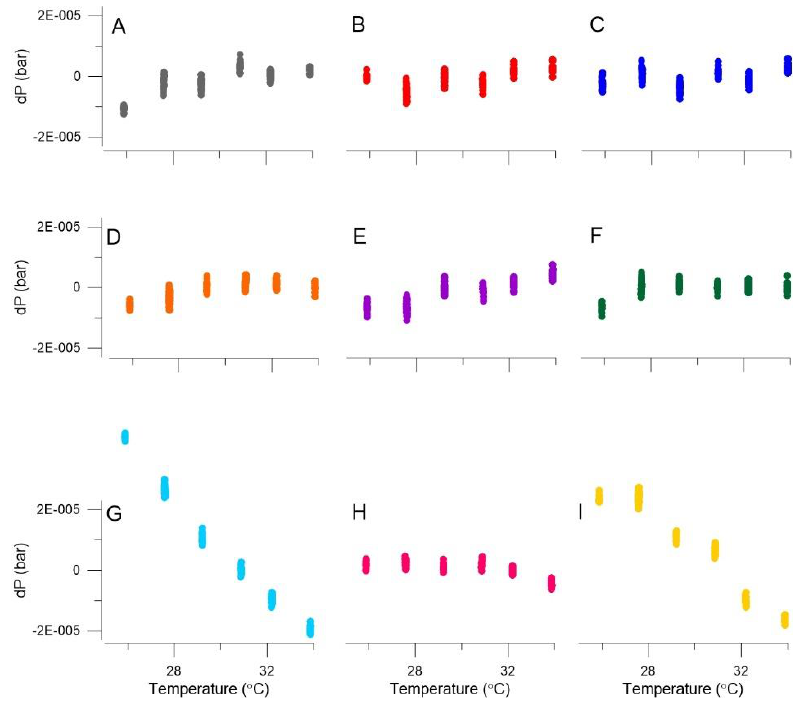
Figure A2. Sensitivity of pressure differences to temperature variations. ( A – I ) Pressure differences of the nine pairs of sensors. The Y -axis is ± 2.3 × 10 − 5 bar (the hydrostatic densitometer resolution).